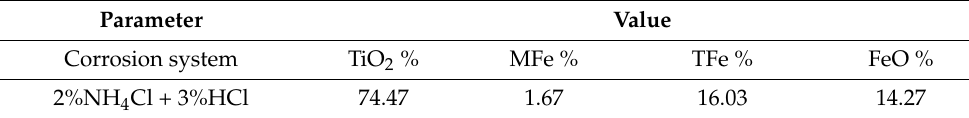
Table 6. Results of corrosion reaction.